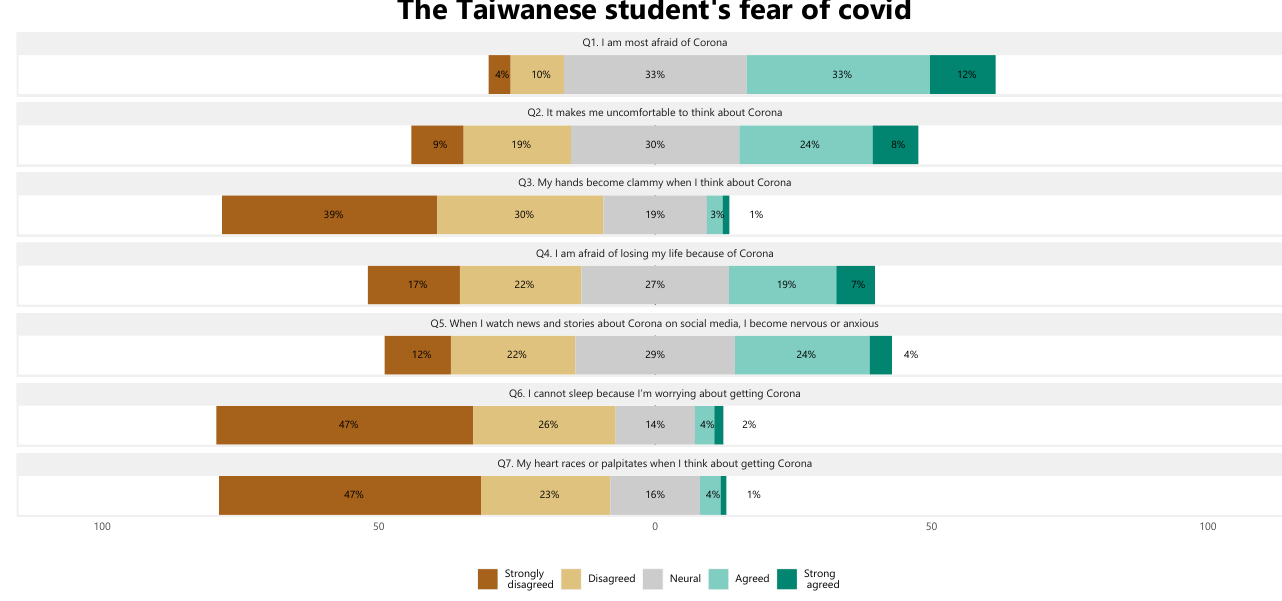
Figure 2. The distribution of the F-CoV questions among Taiwanese